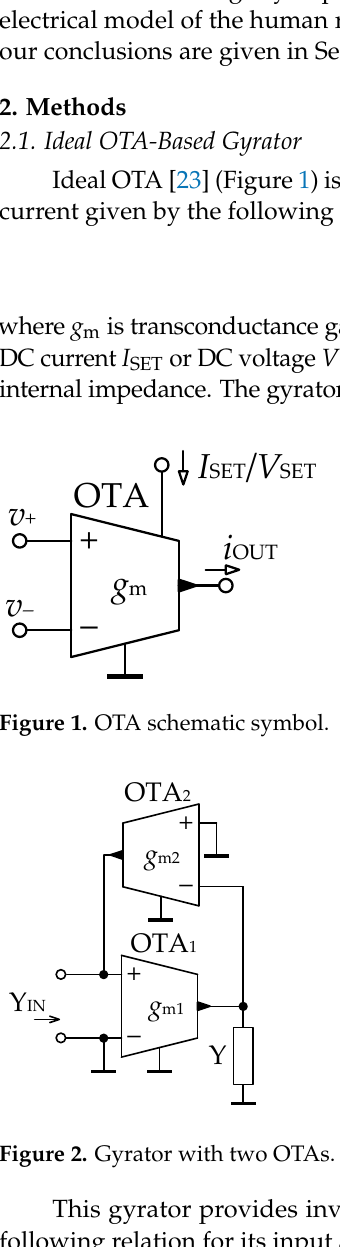
Figure 2. Gyrator with two OTAs.